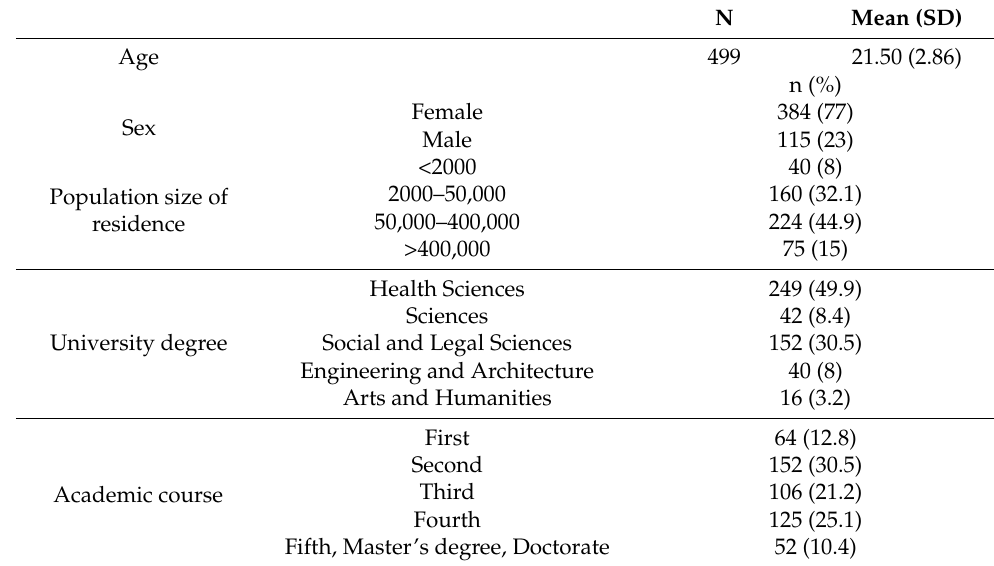
Table 1. Sociodemographic characteristics of the